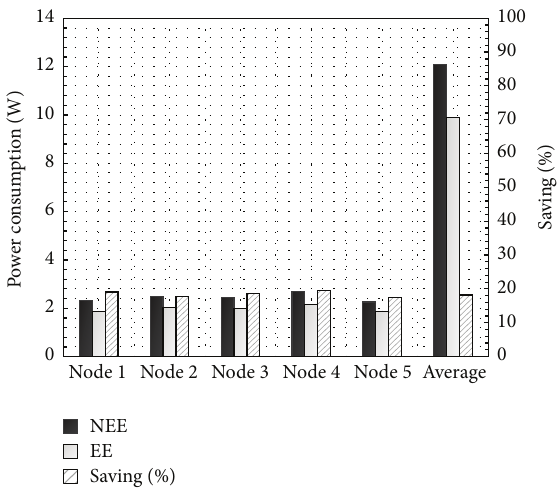
Figure 8: Power consumption with 𝑆 = 5, 𝑁 = 5.